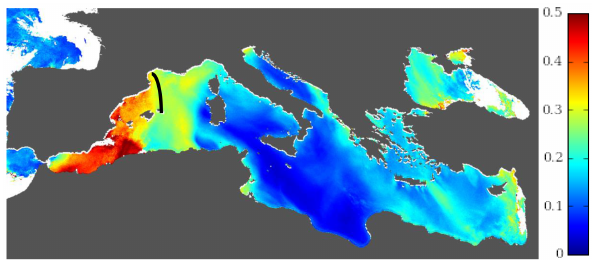
Figure 12. Daytime average aerosol optical depth at 550nm de- rived from MSG/SEVIRI following Thieuleux et al. (2005); browse image courtesy ICARE/LSCE based on MSG/SEVIRI Level-1 data provided by Eumetsat/Eumetcast/LOA). The LOAC balloon trajec- tory is in black.